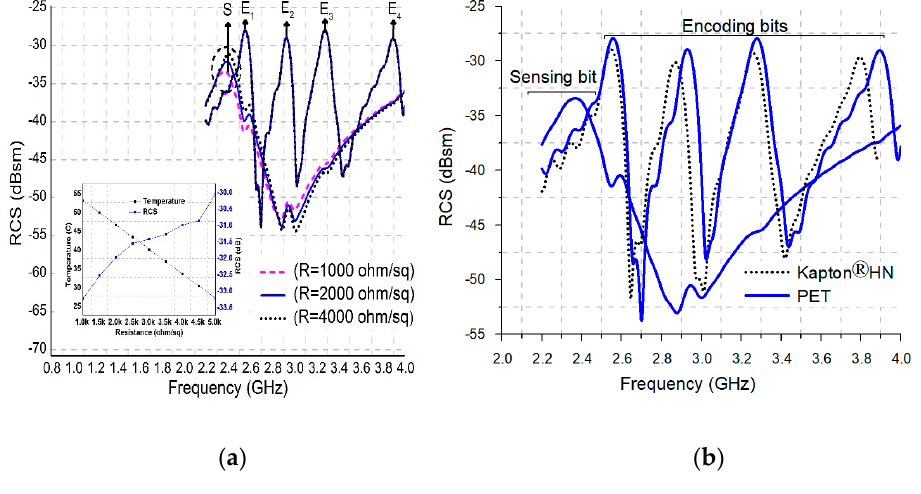
Figure 4. ( a ) Sensing behavior, ( b ) comparison graph.